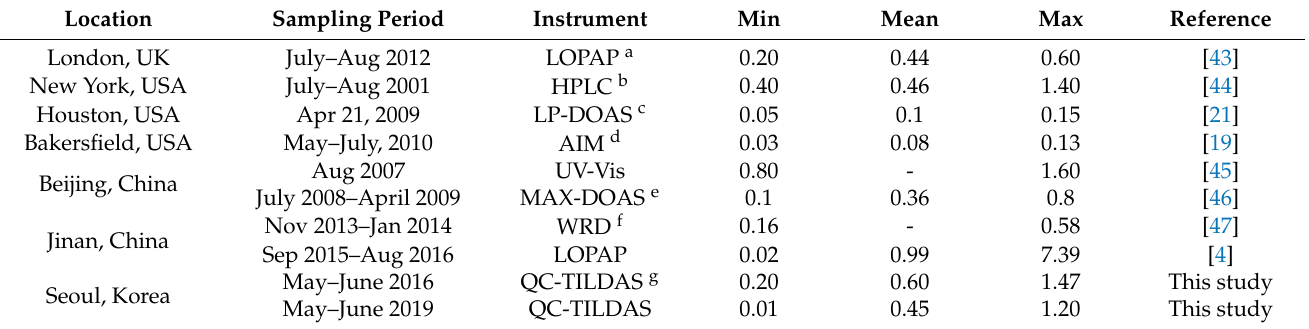
Table 2. Comparison of daytime HONO concentration at various urban sites around the world (unit: ppbv). Location Sampling Period Instrument Min Mean Max